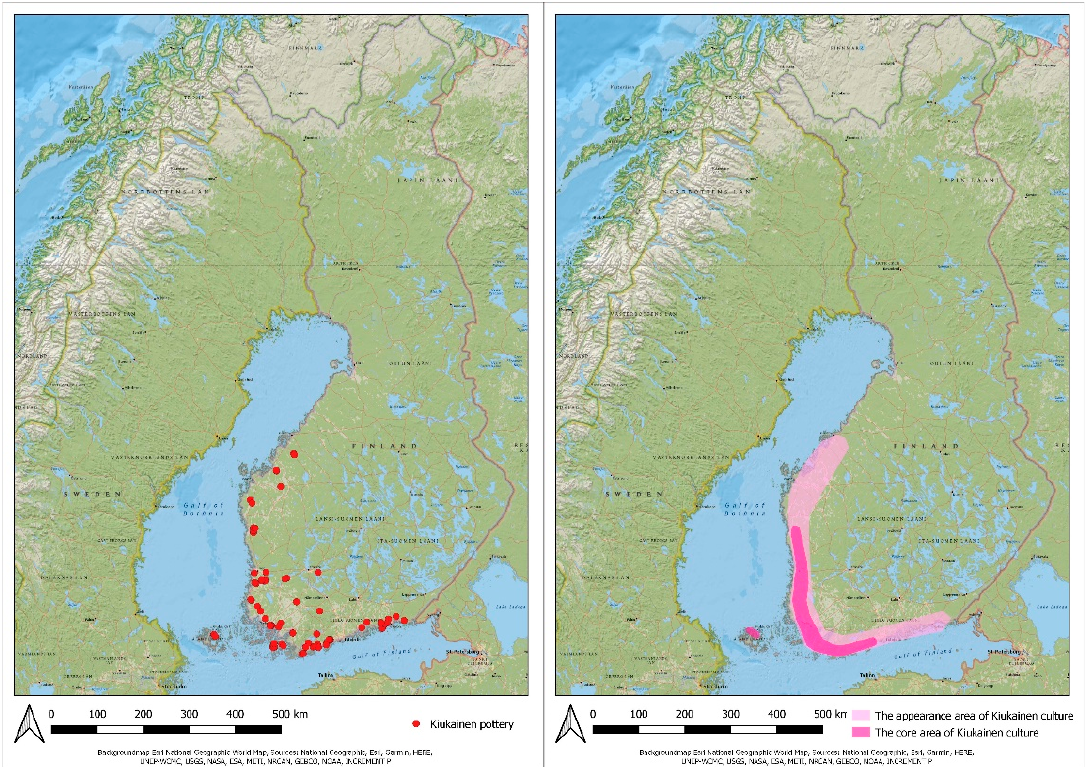
Figure 3. The distribution map of Kiukainen culture ( right ) where individual sites are marked with red dots. The heatmap of the Kiukainen culture ( left ). The heatmap was constructed by evaluating site density and also the number of pottery